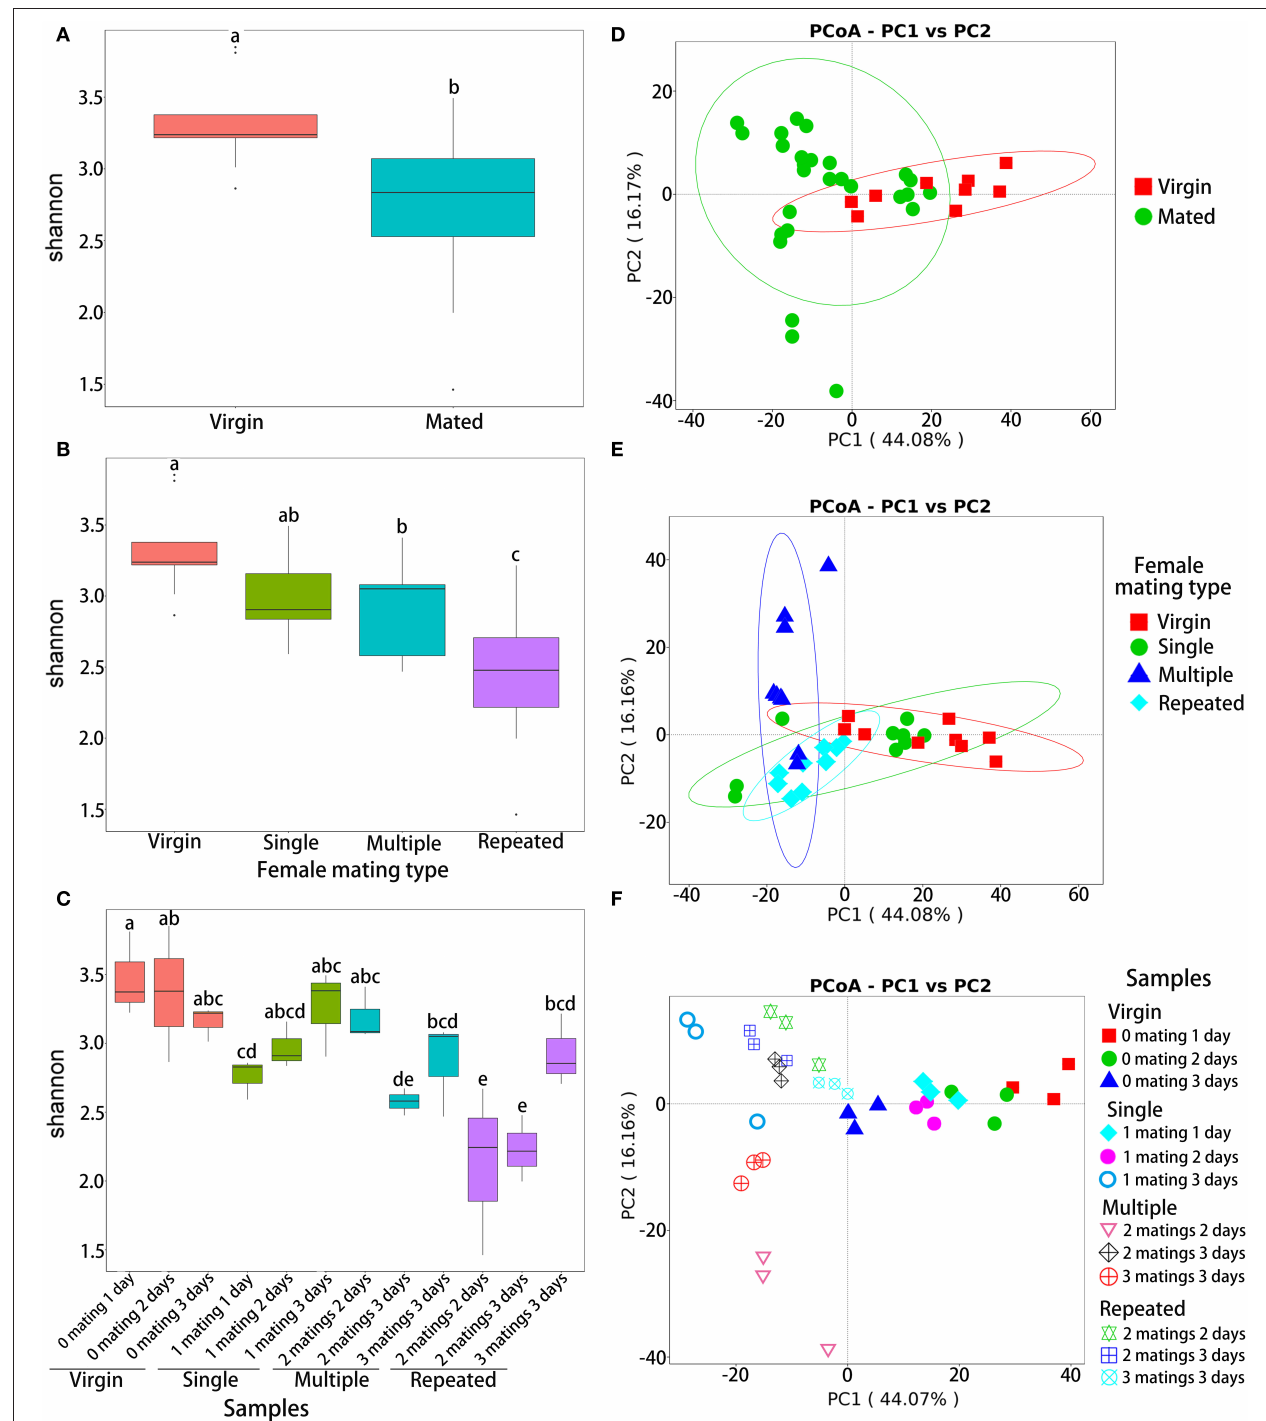
FIGURE 2 | Diversity indices of bacterial OTUs in S. frugiperda females with different mating treatments. Shannon diversity indices of virgin and mated females (A) , females with different mating types (B) , and all samples (C) . PCoA ordination based on Bray–Curtis distances of virgin and mated females (D) , females with different mating types (E) , and all samples (F) . In each of the subgraphs of (a) to (c), bars with different letters are significantly different ( P < 0.05).